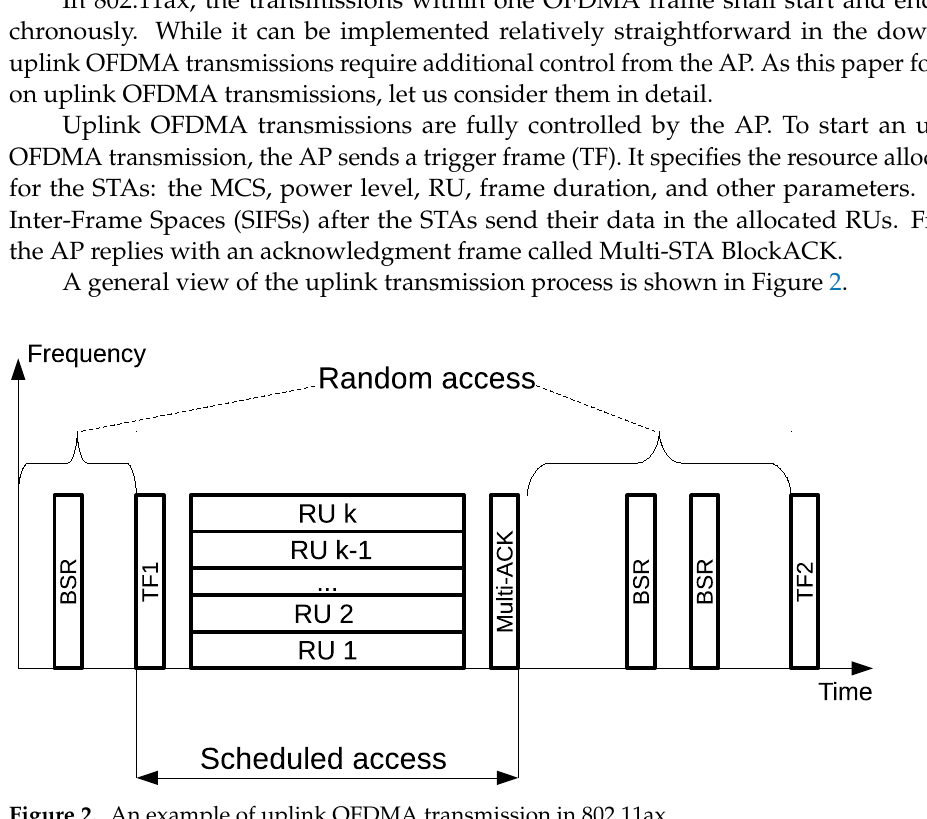
Figure 2. An example of uplink OFDMA transmission in